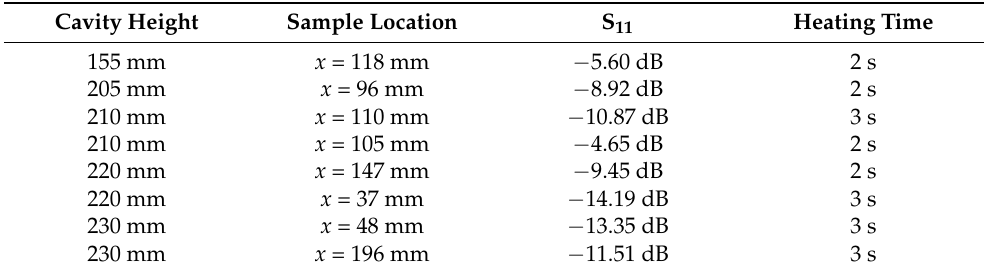
Table 3. The S 11 and heating time at 8 select locations (material: potato).